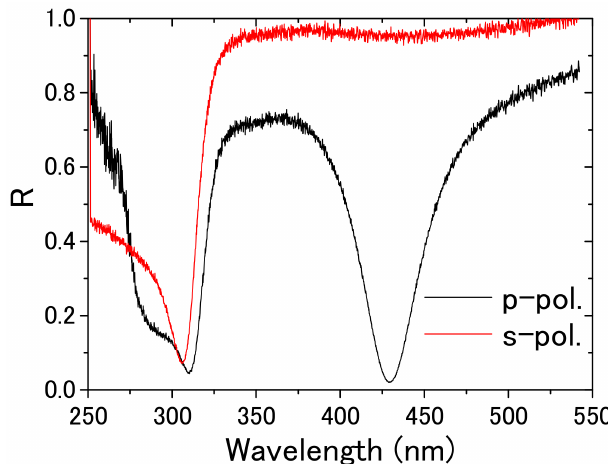
Figure 4. Reflection spectra of Ag with a film thickness of about 50 nm in the Kretschmann arrangement for p- and s-polarized light at an incident angle of >45 ◦ . The dip around 430 nm is due to the surface plasmon resonance appearing only in the reflection spectra for p-polarized light. The dip near 310 nm in the reflection spectra for both p- and s-polarized light is due to the interband transition.